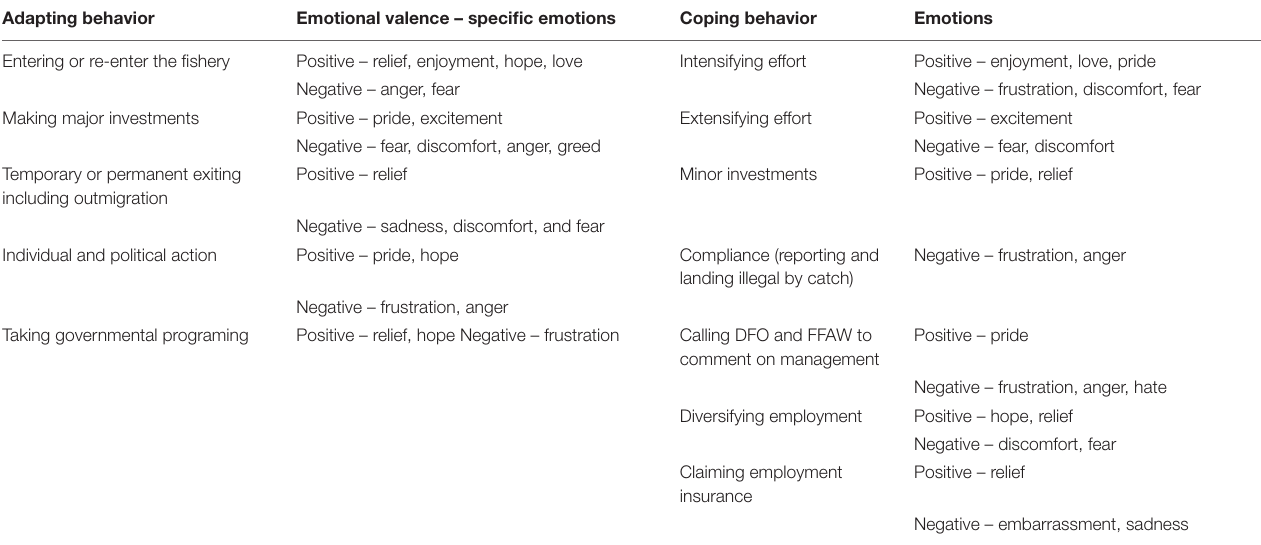
TABLE 3 | Recorded behaviors, the emotional valence, and specific emotions associated with